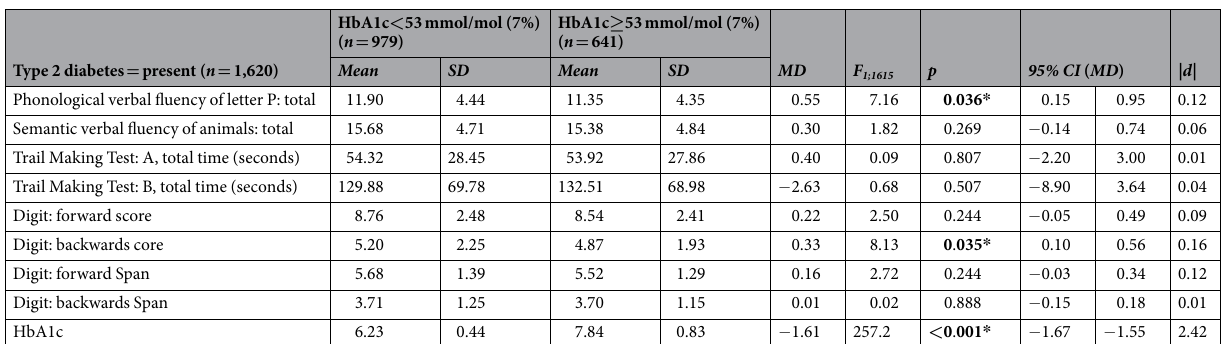
Table 3. Comparison for type 2 diabetes patients with HbA1c higher and lower than 53 mmol/mol (7%). Note . SD, standard deviation; MD, mean difference; | d |, Cohen’s- d measuring effect size. * Bold: